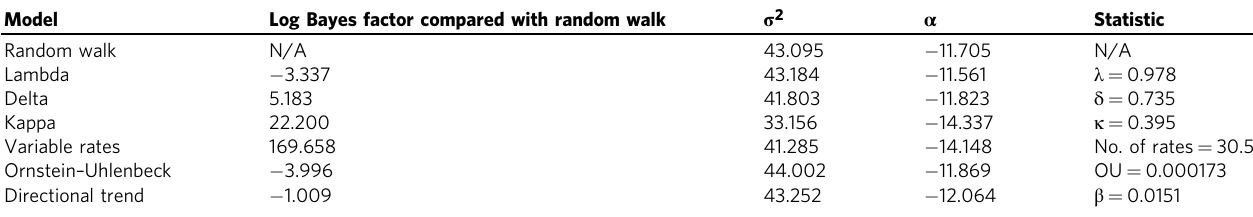
Table 1 Output parameters from each of the phylogenetic models implemented in